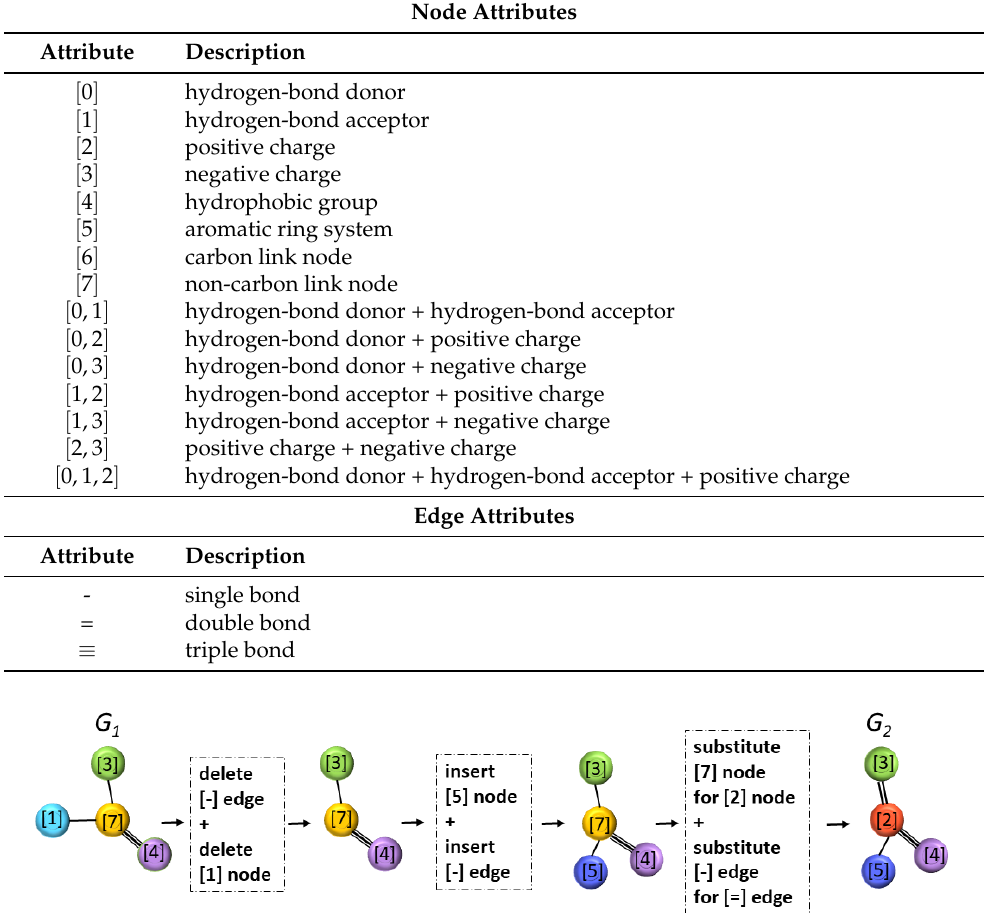
Table 2. Node and edge attributes description in an ErG.